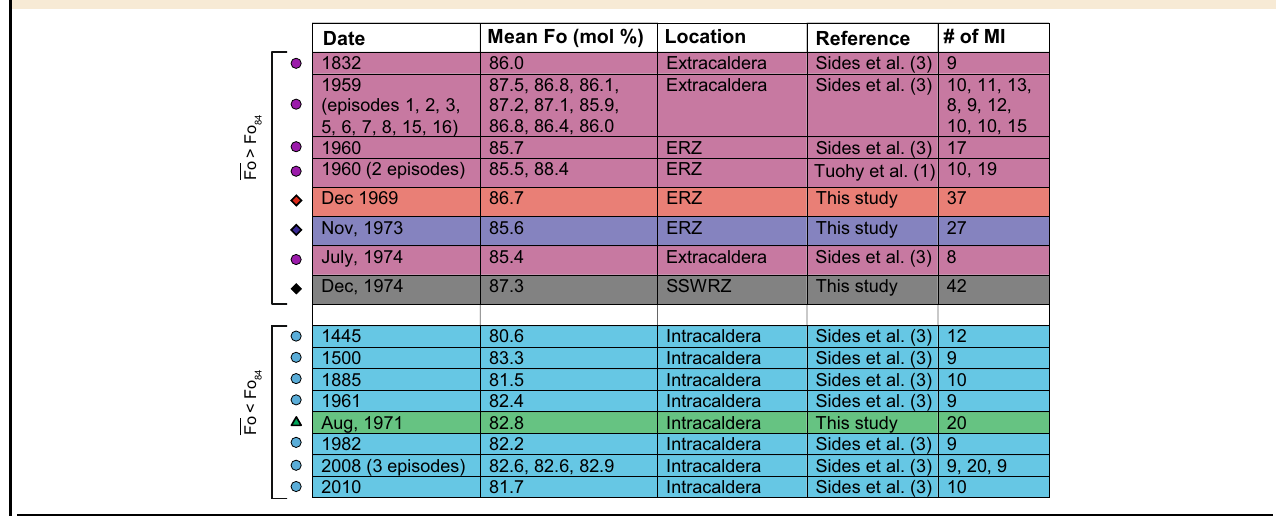
Table 1 Key data on the samples analysed in this study, and those compiled from the literature.